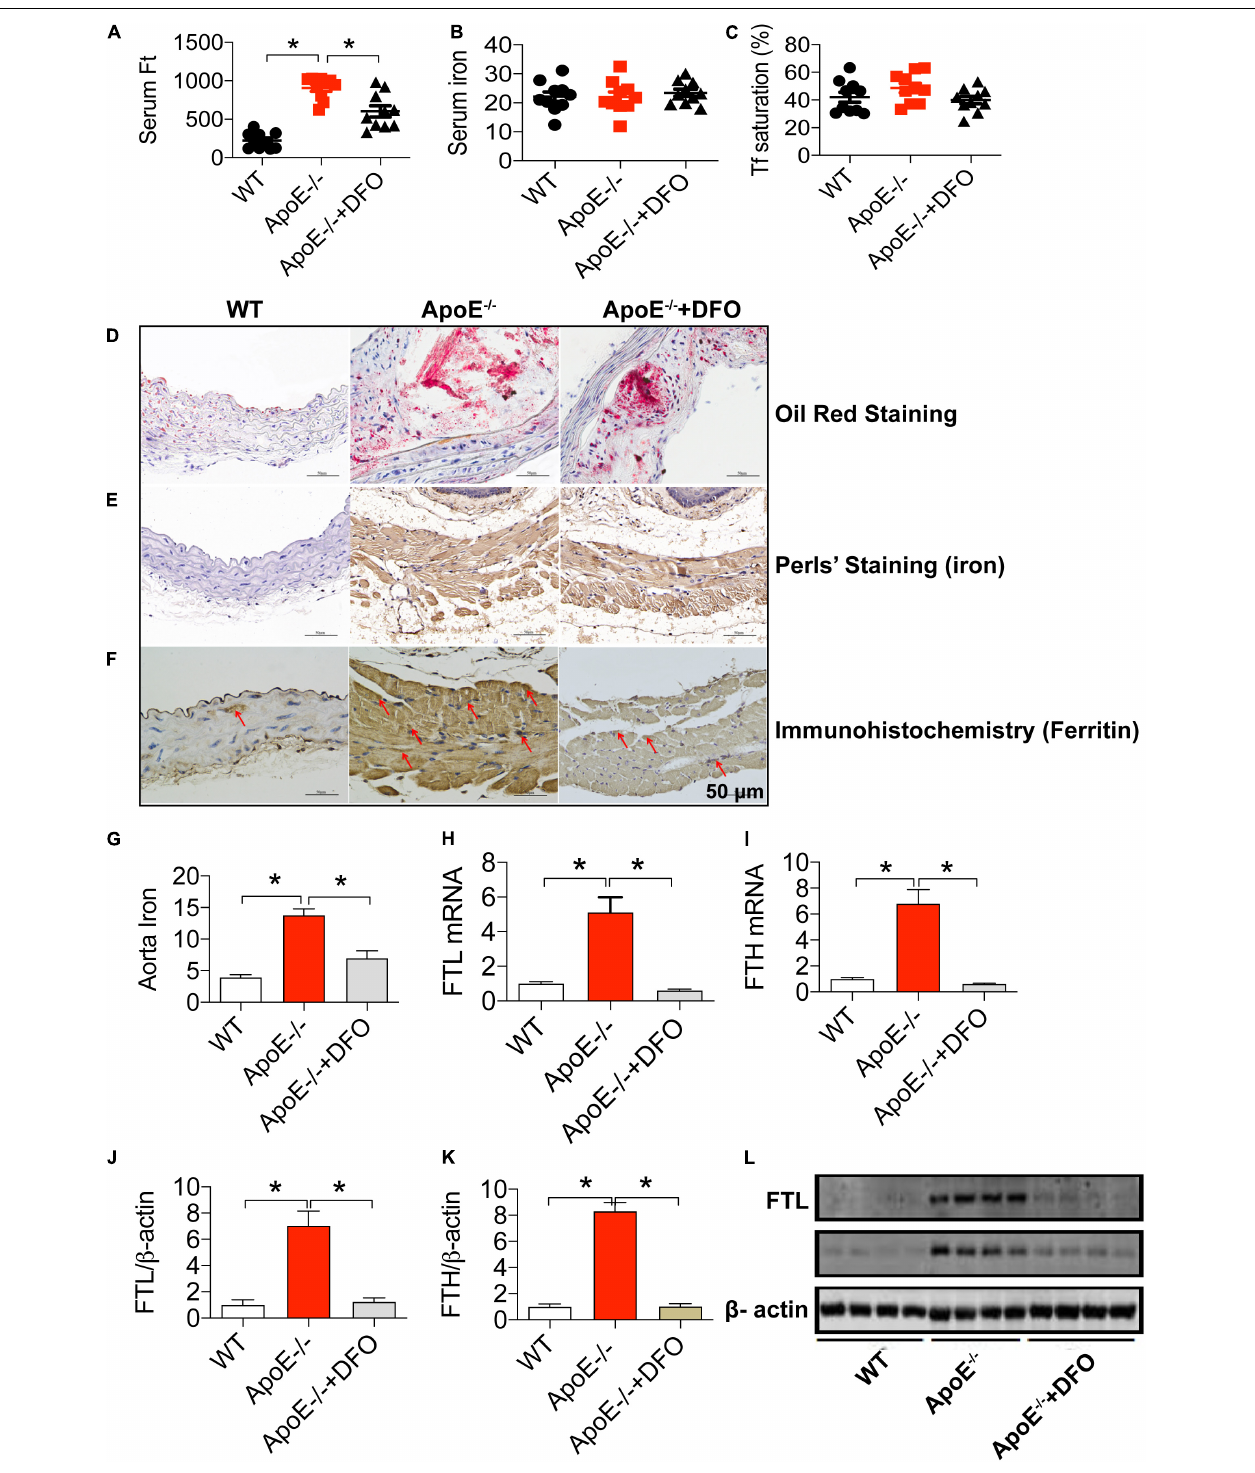
FIGURE 1 | ApoE deficiency resulted in atherosclerosis with a significant increase in serum ferritin and aortic iron and ferritin in mice. The contents of ferritin (ng/mL) (A) , iron ( µ mol/L) (B) and Tf saturation (%) (C) in the serum, and Oil Red O staining (D) , DAB-enhanced Perls’ iron staining (E) , immunohistochemical analysis of FTL protein expression (F) , content of iron (mg/g wet weight) (G) , expression of FTL mRNA (H) , FTH mRNA (I) , FTL protein (J,L) and FTH protein (K,L) in the aortic tissues were determined or performed by the procedures as described in section “Materials and Methods” in WT ( n = 10; WB: n = 4), ApoE – / – ( n = 10; WB: n = 4) and ApoE – / – + DFO ( n = 10; WB: n = 4) mice, all aged 28 week-old. The mice in ApoE – / – + DFO group received daily i.p. injections of 100 mg/kg body weight (b.w.) of DFO in Hanks’ balanced salt solution (HBSS) for 14 days. Scale bar in panels (D–F) = 50 µ m. Data are presented as the mean ± SEM. * p < 0.05.